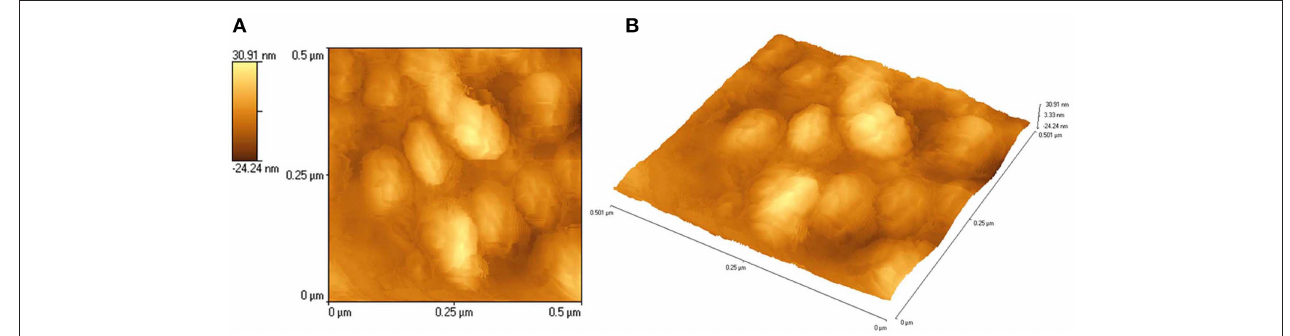
FIGURE 6 | (A) 2D and (B) 3D AFM images of ZnS thin films deposited from ZnCl 2 (cinnamtsczH) 2 at 450 ◦ C.